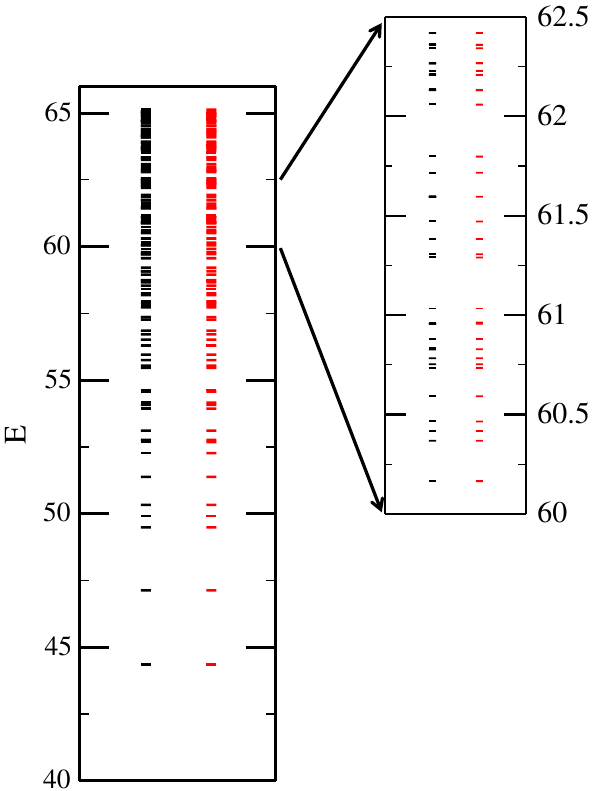
FIG. 10. A plot of the energy spectra for an N ¼ 14 gas with c ¼ 7200 in a cosine potential of amplitude A=E Fig. 2 of the main text). The analytic results are given in red, while in black are the corresponding numerics. On the r.h.s., we expand a range of energy with a dense number of states so as to better exhibit agreement between the numerics and the